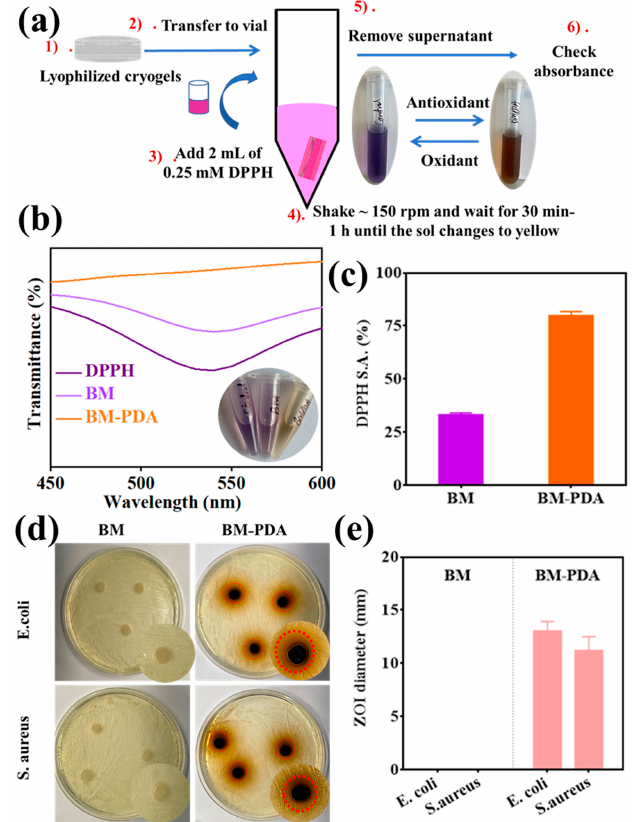
Figure 8. Antioxidant and antibacterial activity with the ( a ) experiment of DPPH assay, ( b ) DPPH radical scavenging activity of BM and BM ˗ PDA, ( c ) DPPH radical scavenging activity (%) as ob- tained by the absorbance, ( d ) pictures of the BM and BM ˗ PDA cryogels’ antibacterial sensitivity to E. coli and S. aureus after 24 h incubation. ( e ) The diameters of the E. coli and S. aureus inhibition zones in the BM and BM ˗ PDA groups (the bar is used to demonstrate the two groups separately). Both Gram-positive and Gram-negative bacteria continuously adapt to their environ- ment and develop medication resistance over time [83]. To overcome bacterial infection, the ongoing development of antibacterial substances that can successfully stop bacterial growth is vital. As a result, we used the agar plate well diffusion method to examine the antibacterial activities of BM and BM ˗ PDA scaffolds against S. aureus (Gram-positive) and E. coli (Gram-negative) bacteria. The inhibition zones formed in a screening test after the cryogel samples were placed in the wells of an agar plate. Excellent antibacterial activity was demonstrated by the PDA-functionalized cryogels against both Gram-positive and